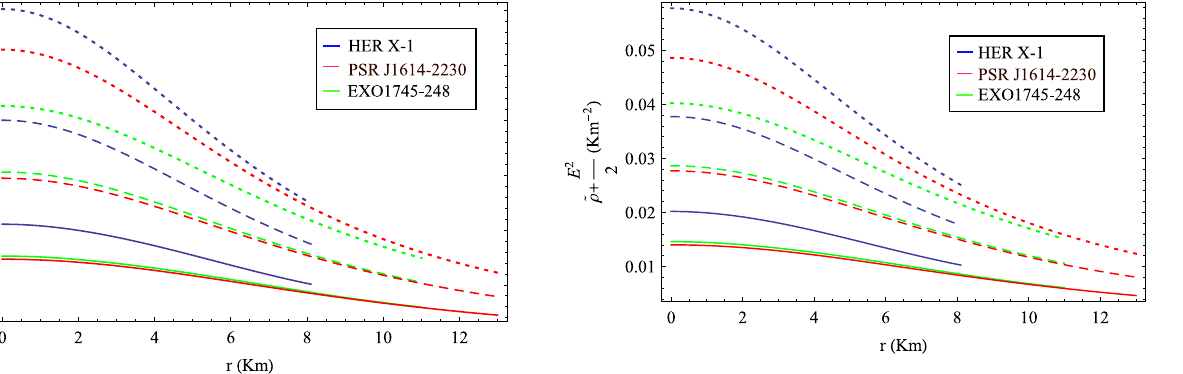
Fig. 12 Radial variation of ˜ ρ + E 2 for different compact objects as 2 indicated in the figure. Here plots with solid, dashed and dotted lines correspond to D = 4 , 5 and 6 respectively. To obtain the plots we choose (i) α = 0 . 4, γ = 0 . 45 when D = 4; α = 0 . 3, γ = 0 . 25 when D = 5 and α = 0 . 25, γ = 0 . 2 when D = 6 for HER X-1, (ii) α = 0 . 4, γ = 0 . 5 when D = 4; α = 0 . 3, γ = 0 . 25 when D = 5 and α = 0 . 2, γ = 0 . 15 when D = 6 for PSR J1614-2230, (iii) α = 0 . 4, γ = 0 . 5 when D = 4; α = 0 . 3, γ = 0 . 2 when D = 5 and α = 0 . 2, γ = 0 . 25 when D = 6 for EXO1745-248